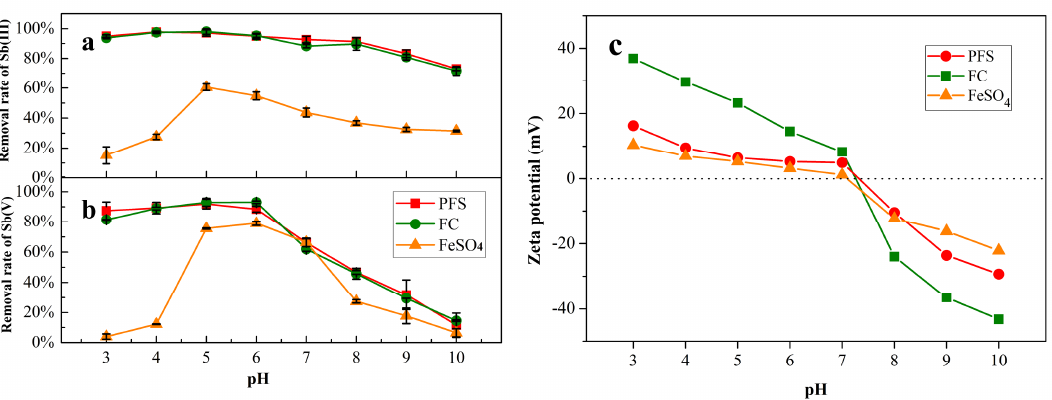
Figure 1. E ff ects of pH on ( a ) Sb(III) and ( b ) Sb(V) removal with 10 mg · L − 1 of PFS, FC, and FeSO 4 (initial Sb(III) and Sb(V) concentrations: 200 µ g · L − 1 ). ( c ) Zeta potential of PFS, FC, and FeSO 4 (PFS, FC, Figure 1. Effects of pH on ( a ) Sb(III) and ( b ) Sb(V) removal with 10 mg·L −1 of PFS, FC, and FeSO 4 and FeSO 4 concentrations: 30 mg · L − 1 as Fe). PFS: polymeric ferric sulfate; FC: ferric (initial Sb(III) and Sb(V) concentrations: 200 μg·L −1 ). ( c ) Zeta potential of PFS, FC, and FeSO 4 (PFS, FC,